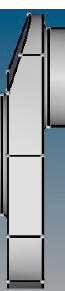
Figure 4. The structure feature of the six-cylinder engine crankshaft.